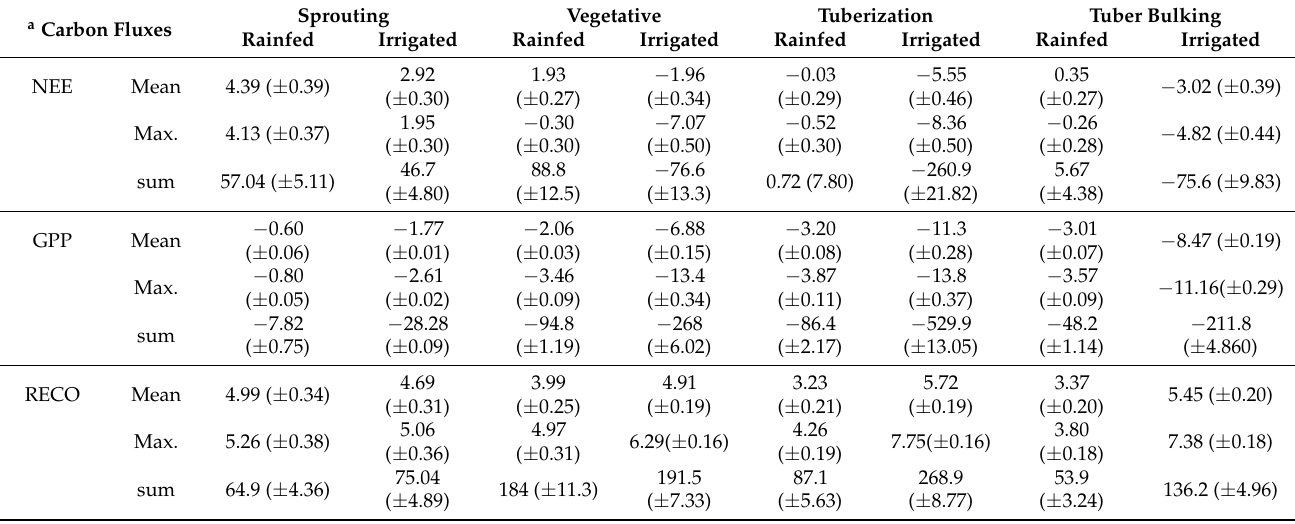
Table 1. Mean, maximum, and sum of carbon fluxes throughout growth stages at Rainfed and Irrigated. a Carbon